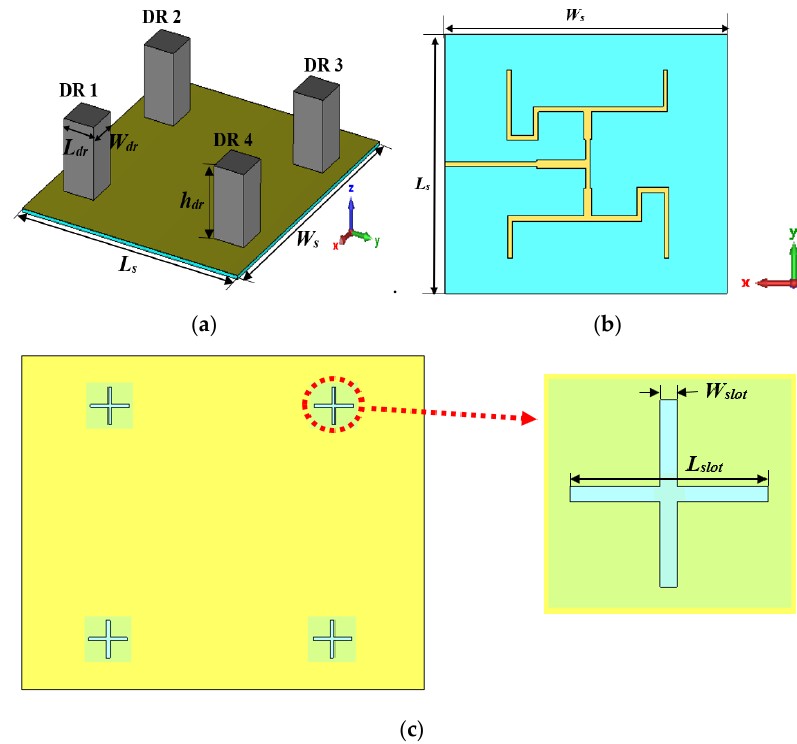
Figure 1. Proposed DRA. ( a ) Perspective view; ( b ) back view; ( c ) ground plane. The proposed antenna is excited by a single source. Equal power distribution to the elements is realized using a feeding network with T-junction dividers. The desired phase difference between adjacent elements is achieved by optimizing the lengths of the feed lines and the geometry of the feeding network. The feeding network of UCA is shown in Figure 2. Port 1 is the input port, whereas port 2, port 3, port 4, and port 5 are the output ports used to excite DR 1, DR 2, DR 3, and DR 4, respectively. A 90° phase difference be- tween ports 2 and 3 was obtained by altering the length of the feedline, as illustrated in Figure 2b. Ports 2 and 3 are the mirror image of ports 4 and 5. The mirror image arrange- ment of the feeding network was adopted for the simplicity of the design. The overall phase difference for port 2, port 3, port 4, and port 5 were −97.85°, −0.58°, −93.36°, and −0.22°, respectively, as shown in Figure 3a. The additional 180° phase shift due to the mir- ror image of the feeding network gives port 4 a phase shift of 86.64° and port 5 a phase shift of 179.78°. Thus, the incremental phase shifts for the proposed antenna were −97.85°, −0.58°, 86.64°, and 179.78°. The phase differences were as follows: 97.27° between ports 2 and 3; 87.22° between ports 3 and 4; 93.14° between ports 4 and 5; and 98.07° between Figure 2. Feeding network. ( a ) Structure of the feeding network; ( b ) location of the ports. ports 5 and 1. It has been observed from the simulated result that the obtained values are close to 90°. Moreover, the amplitudes for all four ports were very similar, as shown in Figure 3b. The amplitudes for port 2, port 3, port 4, and port 5 were −9.41 dB, −10.84 dB, −9.23 dB, and −10.46 dB, respectively. The dimensions of all parameters are well optimized to resonate at 3.2 to 3.66 GHz, and the details of the parameters are shown in Table 1. ( a ) ( b ) Figure 3. Simulated results of the feeding network. ( a ) Phase shifts between the elements; ( b ) am- plitude. Table 1. The dimensions of the proposed DRA. Parameters Values (mm) Parameters Values (mm) Parameters